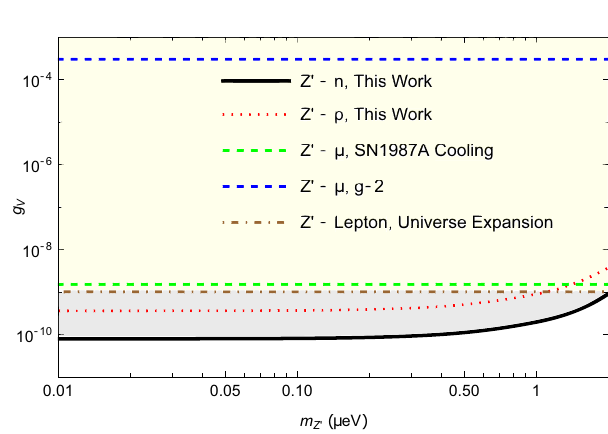
Fig. 5 | The experimental limits on the vector coupling constant g V of the Z ’ particle. The black solid line and red dotted line are set by this work by searching for the exotic spin-dependent force. The blue dashed line is set by the g − 2 experiment 41,44,45 ,thebrowndotted-dashedlineissetbytheneutrinoproductionin the expansion of the early universe 41 , the green dashed line, is from the analysis of the supernova SN1987 cooling 44 . The shaded areas are the parameter space excluded by the corresponding